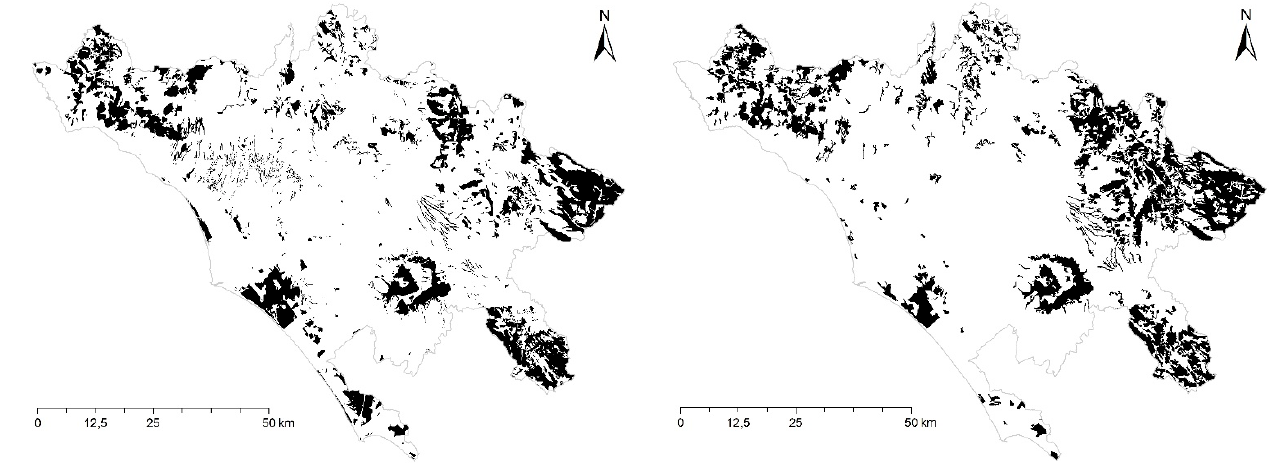
Figure 4. The spatial distribution of forest cover in the study area in 1936 ( left ) and in 2018 ( right ), based on elaboration on the forest maps described above.